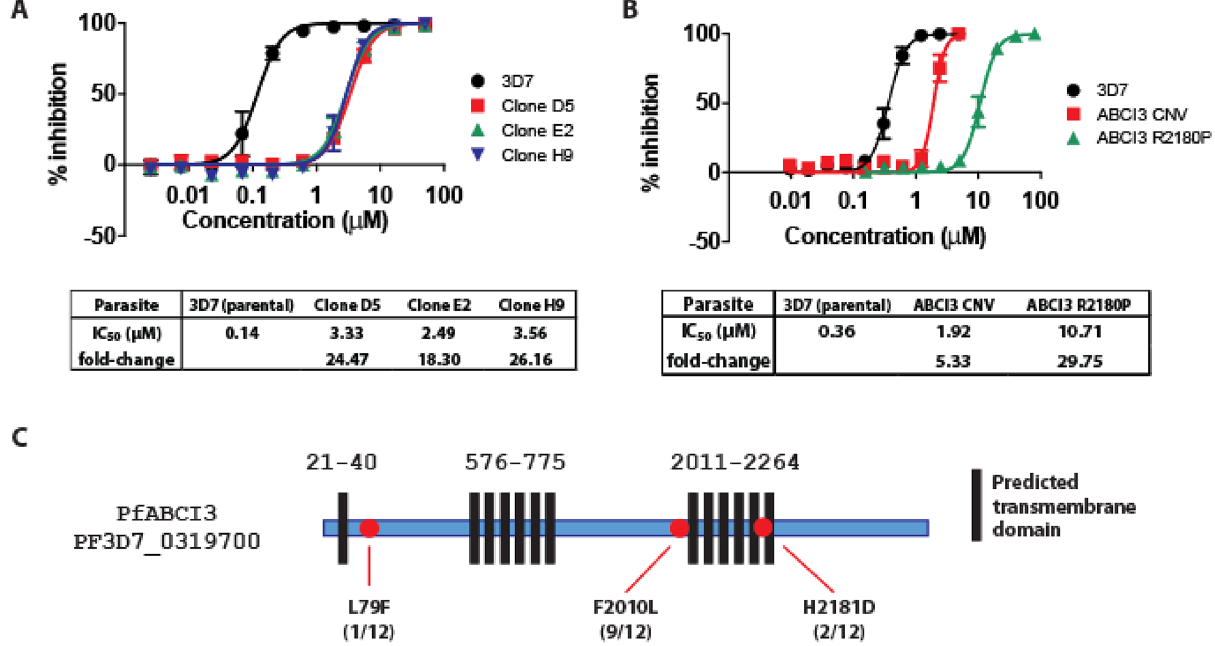
Figure 3. The generation and genotyping of parasite resistance to DDD01034957. ( A ) After selection pressure, DDD01034957 was less efficacious against drug-resistant clonal parasite lines compared to the parental 3D7 line. The graph illustrates a shift in efficacy of three representative clones. Error bars denote the SEM based upon three independent repeats. ( B ) DDD01034957 was also less efficacious against a pfabci3 copy number variant parasite line and a mutant line harbouring the pfabci3 R2180P mutation. Error bars denote the SEM based upon at least three independent replicates. ( C ) Whole-genome sequencing of twelve clones from the selection protein. Protein transmembrane predictions calculated by PlasmoDB (https ://plasm odb.org/plasm